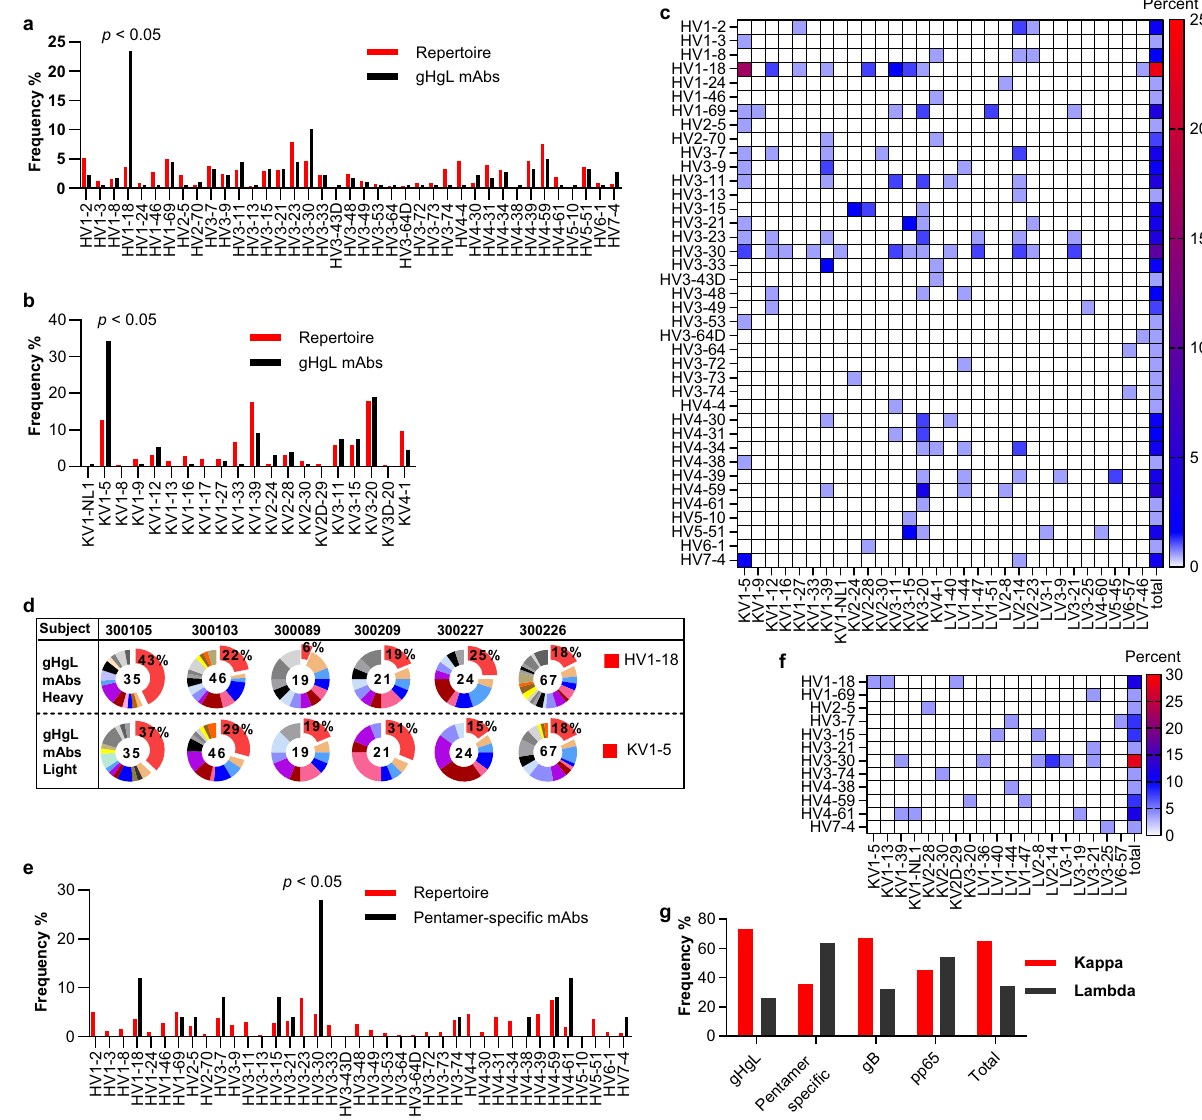
Fig. 6 The germline usage of gHgL and pentamer-speci fi c antibodies. a Heavy chain variable region germline gene distribution of gHgL mAbs in the six subjects (black bars), compared to the naive variable region gene repertoire (red bars). b The kappa chain variable region germline gene distribution of gHgL mAbs in the six subjects (black bars), compared with the naive variable region gene repertoire (red bars). c Heatmap frequency of V-gene usage of the paired gHgL antibodies. d The pie chart of antibody variable region gene germline distribution in each subject for the gHgL antibodies. Red color indicates the HV1-18 germline, and the KV1-5 germline. The numbers of antibodies of each subject are shown in the middle of the pie. The percentage of HV1-18, and KV1-5 germline are indicated. e Heavy chain variable region gene germline distribution of the pentamer-speci fi c mAbs in the six subjects (black bars), compared to the naive variable region gene repertoire (red bars). f Heatmap frequency of V-gene usage of the paired antibodies to pentamer. g The light-chain pairing preference of mAbs to different HCMV antigens. The reference naive antibody variable region gene repertoire is from a previous study 36